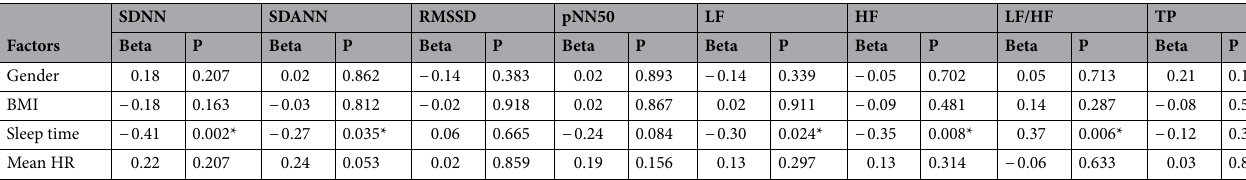
Table 3. Factors associated with pre- and post-call heart rate variability alterations using multiple linear regression analysis. BMI body mass index; HF high frequency; HR heart rate; LF low frequency; LF/HF low frequency/high frequency ratio; pNN50 percentage of successive RR intervals that differ by more than 50 ms; RMSSD root mean square of successive RR interval differences; SDNN standard deviation of NN intervals; SDANN-SD of the average NN intervals; TP total power (sum of very low frequency, LF, and HF power) (ms 2 ). * P value < 0.05.